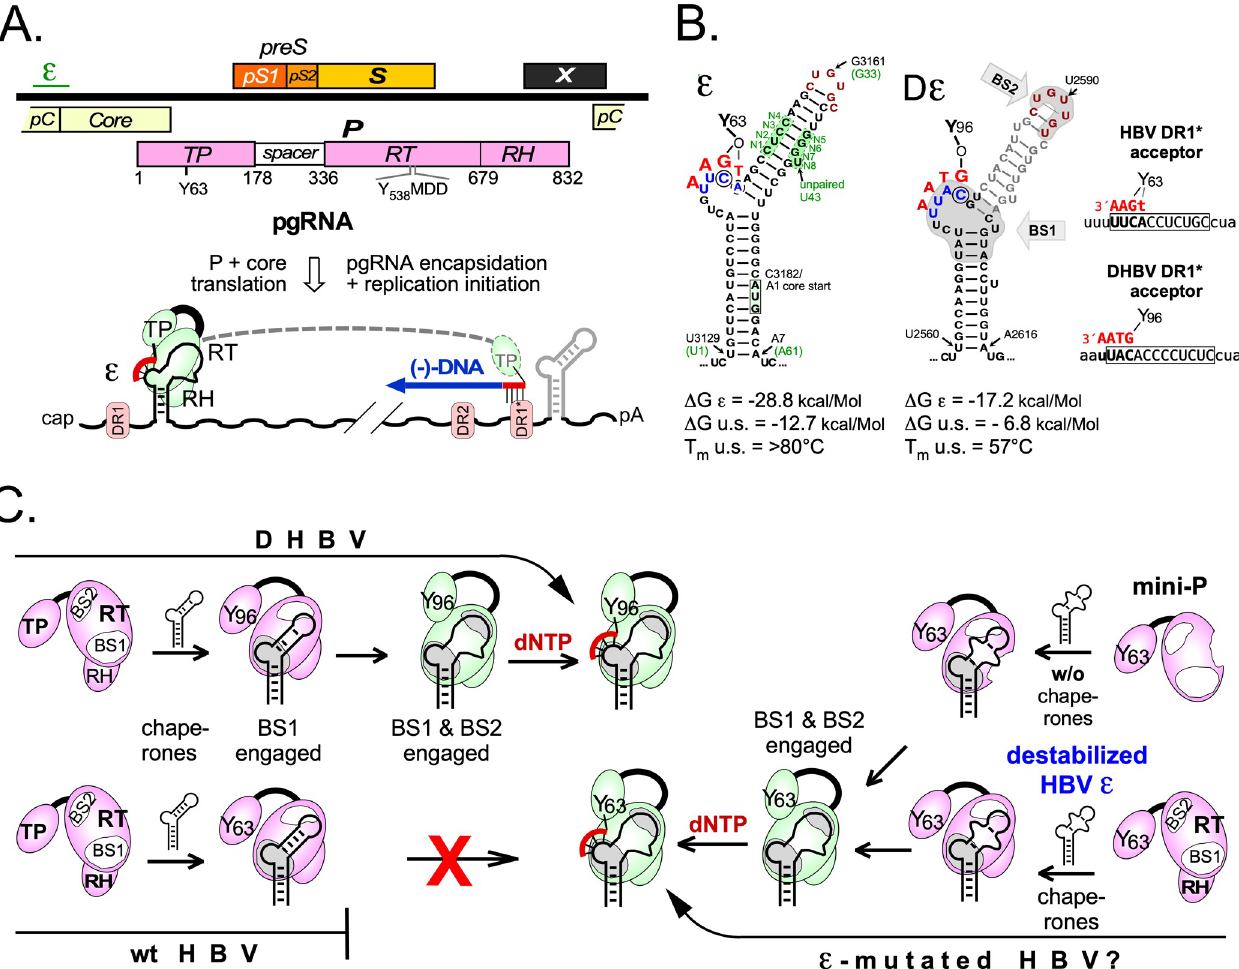
Fig 1. Basic features of HBV replication. (A) Linearized version of the HBV genome. The 3.2 kb genome is symbolized by the black line, ORFs by colored bars; ε shows the location of the RNA encapsidation signal. S, surface antigen; X, HBx; P, polymerase; pC, preC; pS1, preS1, pS2, preS2. Domains of P protein with approximate borders (in amino acid positions) are denoted as TP (Terminal Protein), RT (Reverse Transcriptase) and RH (RNase H), Y63 refers to the Tyr acceptor for the first primer nucleotide, Y538MDD to RT active site residues. Terminally redundant pg RNA mediates translation of P and core. P binding to 5´ ε initiates pgRNA encapsidation and synthesis of a DNA oligo (red) that after transfer to an acceptor site at direct repeat DR1 � is extended into full-length minus-strand DNA (blue); plus-strand DNA synthesis and degradation of the copied RNA yield partially double-stranded RC-DNA. (B) Secondary structures of HBV ε and DHBV ε (D ε ). The structures and free energies ( Δ G) for the entire stem-loops and just the upper stems (u.s.) are as predicted by M-FOLD, supplemented by experimental melting temperatures (T m ) for just the upper stems [38]. For ε black numbers refer to genome positions relative to the starting A of the core ORF as position 1; green numbers to positions within the stem-loop only. Y63 and Y96 denote the priming HBV and DHBV TP Tyr residues. D ε regions BS1 and BS2 (grey background) are likely interaction sites with DHBV P [30]. The DR1 � acceptor sites for the (D) ε templated primers are shown on the right. (C) Hepadnaviral protein priming. The model is based on in-cell and in vitro data for DHBV. Accordingly, chaperones activate P for D ε binding via interaction with BS1 (bulge region). Only a subsequent interaction with BS2 (UG-rich apical sequence) and conformational rearrangements in the RNA enable P (symbolized by the green coloring) to initiate DNA synthesis at Y96. The central hypothesis of this study is that the P- ε complex from HBV, unlike that from DHBV, is unable to progress, in vitro, beyond BS1 binding because the higher stability of the upper stem impairs the necessary rearrangement. Mutations that reduce basepairing but maintain ε functionality might enable DHBV analogous in vitro priming systems, including chaperone-independent formats based on truncated miniP proteins. catalyzed by P protein´s reverse transcriptase (RT) domain. Limited extension on the ε bulge yields a 3–4 nt oligonucleotide which, still bound to TP, is translocated to an acceptor at the 3´ direct repeat, DR1 � (Fig 1A and 1B). Extension from there and concomitant degradation of pgRNA by P´s RNase H (RH) domain generate single-stranded (ss) minus-strand DNA. The 5´ terminal pgRNA residues are spared from degradation and prime plus-strand DNA